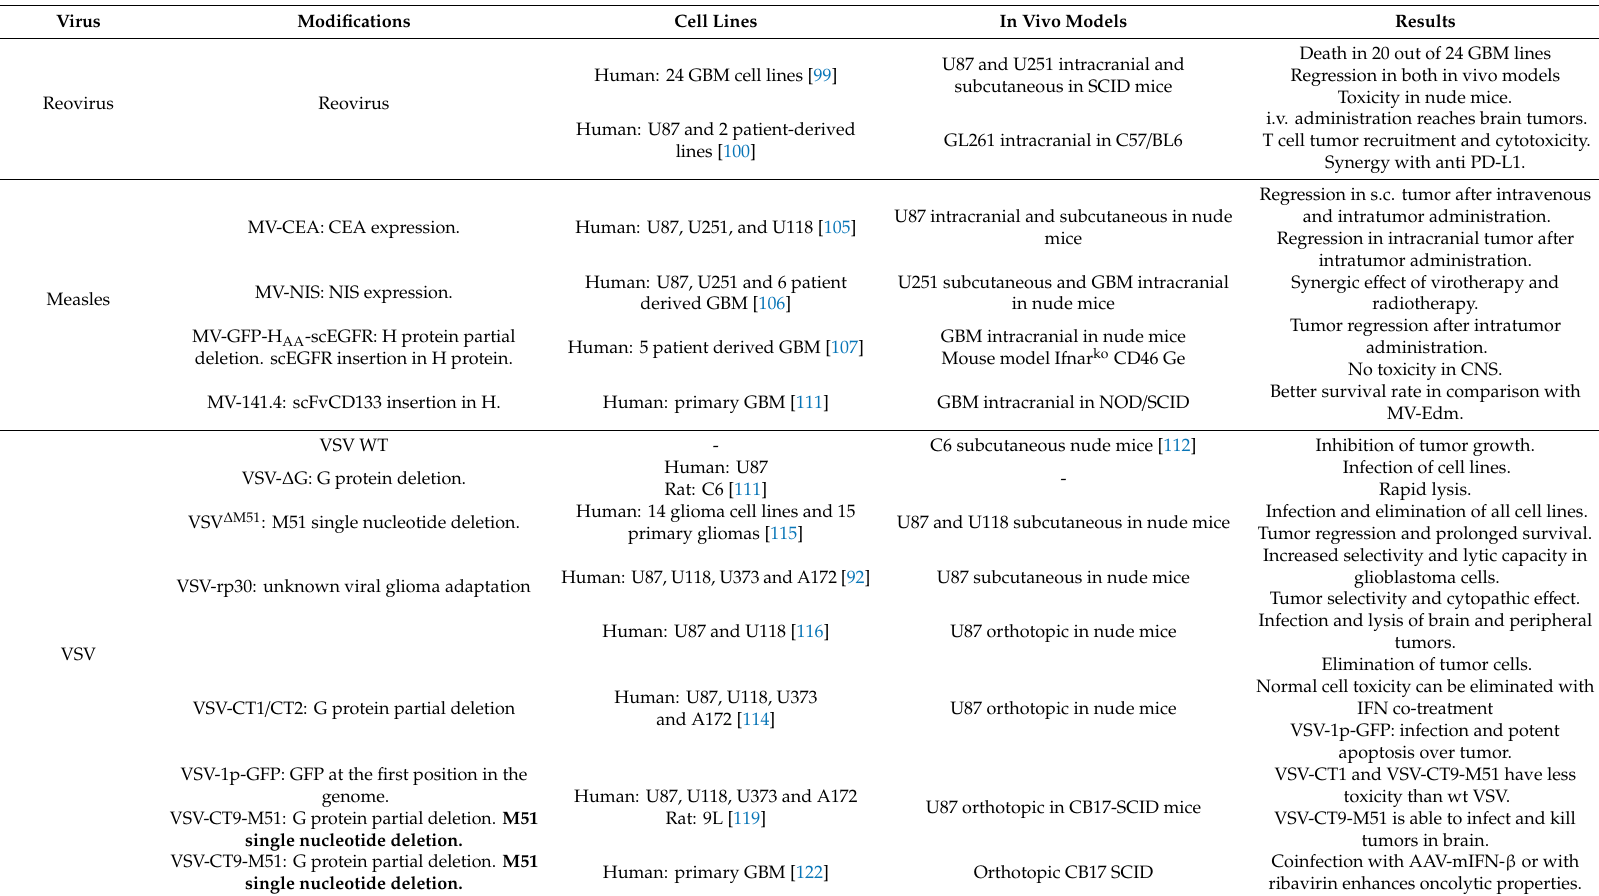
Table 2. Preclinical studies of RNA viruses in glioma